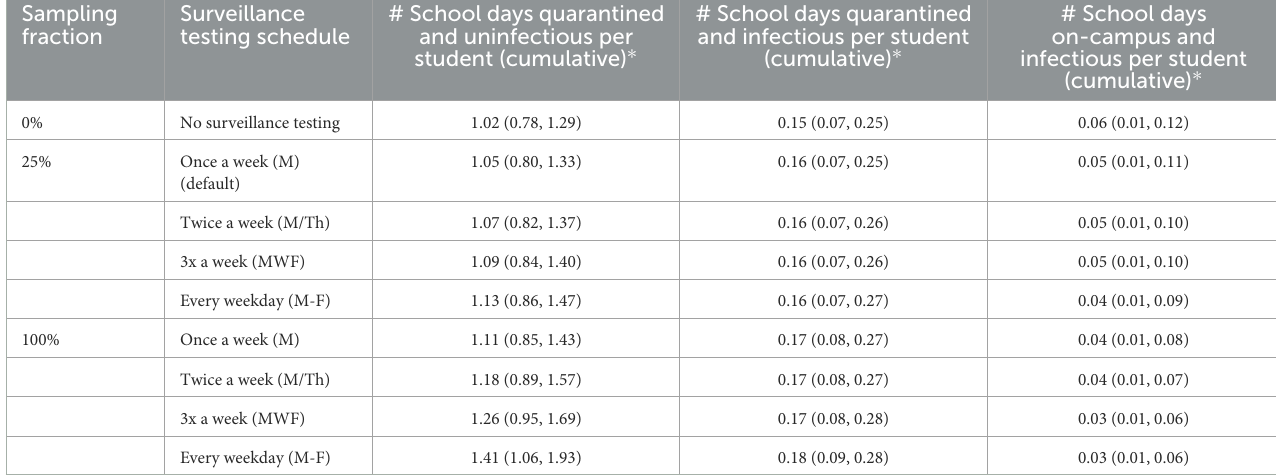
TABLE 3 Additional mean-average outcomes after 2 months of in-person instruction, by surveillance testing frequency and sampling fraction. Sampling